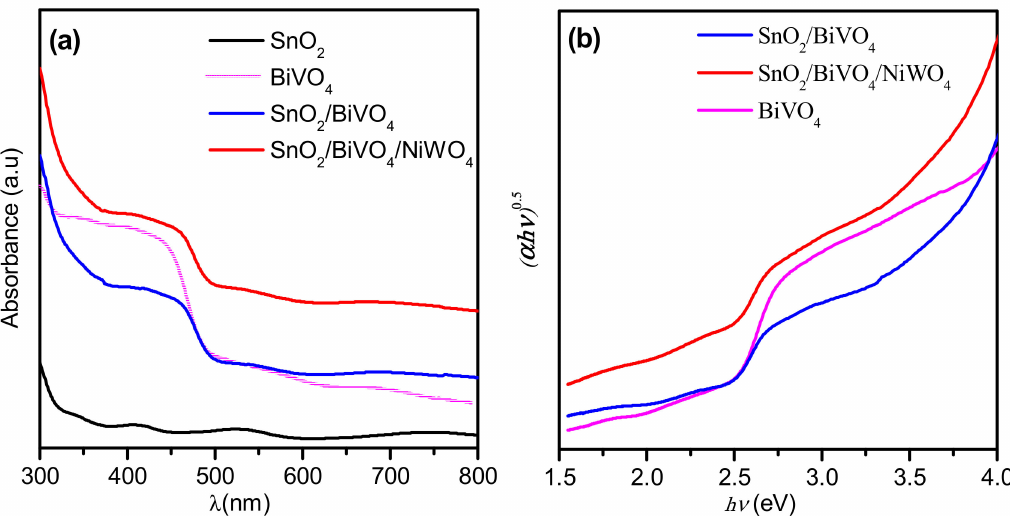
Figure 4. Optical properties of the photoanodes ( a ) UV-Vis absorption spectra of SnO 2 , BiVO 4 , BiVO 4 / SnO 2 , and NiWO 4 / BiVO 4 / SnO 2 electrodes deposited on FTO substrates. ( b ) The corresponding Tauc plots of NiWO 4 / BiVO 4 / SnO 2 electrodes with respect to BiVO 4 and BiVO 4 / SnO 2